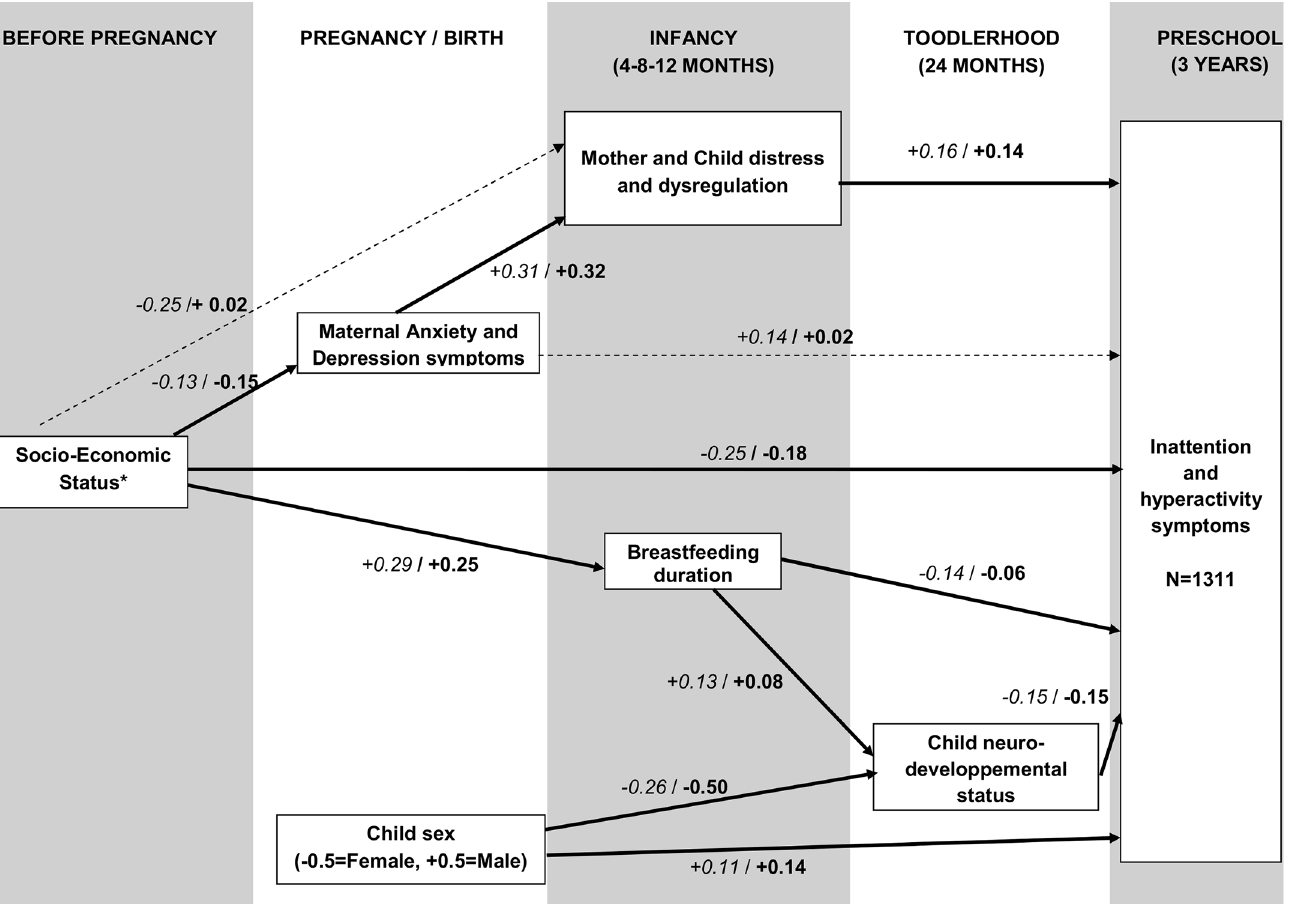
Fig 3. Longitudinal model of inattention-hyperactivity symptoms emergence (4 th step). * Prenatal tobacco and maternal age at birth were proxies of SES. Italicized coefficients are bivariate correlation coefficients. Bold coefficients are standardized path coefficients. A solid arrow indicates a statistical significance (p < 0.05) of the multivariate path coefficient A dotted arrow indicates a bivariate significance that disappears in the multivariate model.